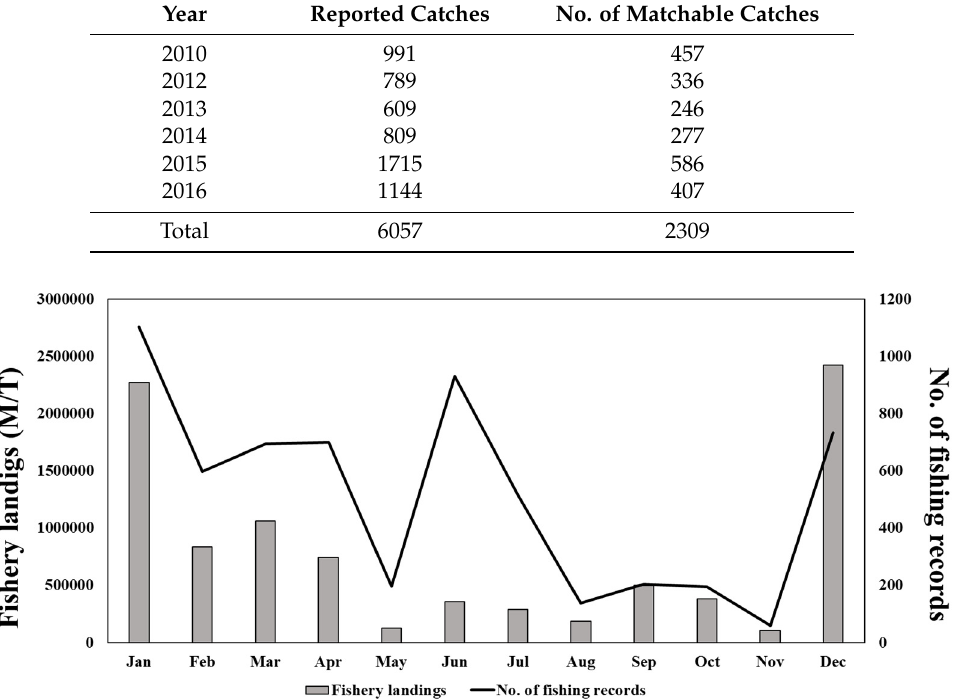
Table 1. The number of commercial catch data matched with 8-day composited MODIS-Aqua datasets.